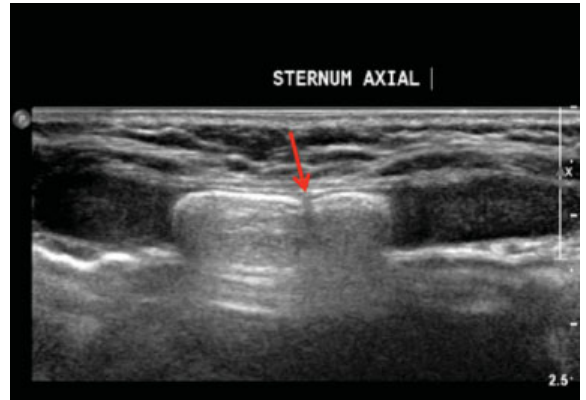
Fig. 4 Transverse ultrasonic image showing the transverse, nondis- placed fracture of the corpus sterni (indicated by